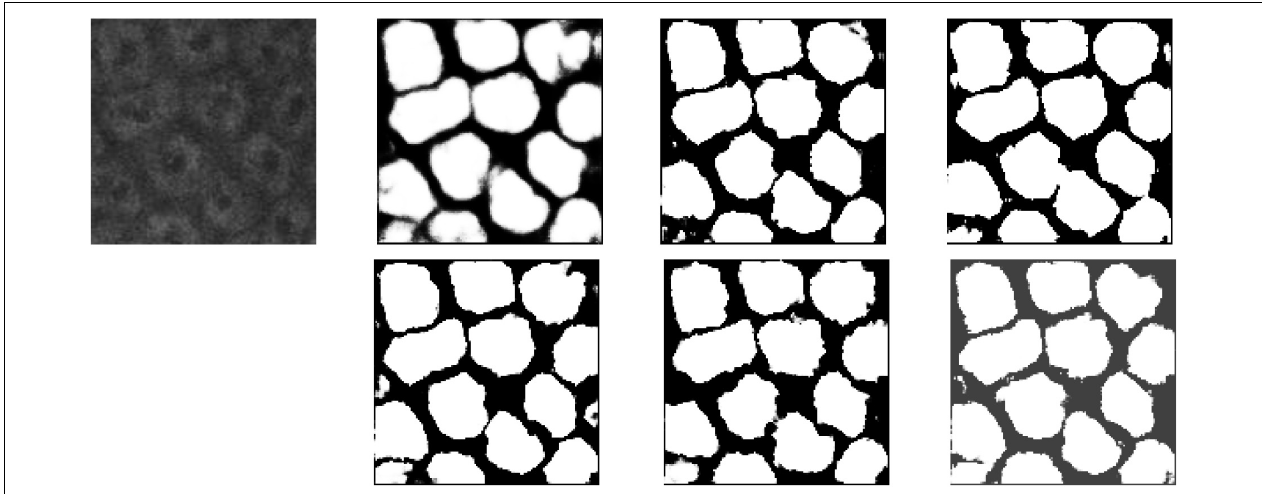
FIGURE 11 | Segmentation results for MPM dataset. Row 1, column 2: UNet; row 1, column 3: UNet + + (L4); row 1, column 4: dilated UNet(L2); row 2, column 2: DHP-horizontal EUNet; row 2, column 3: U ∗ UNet; row 1, column 4: U ∗ U ∗ UNet.